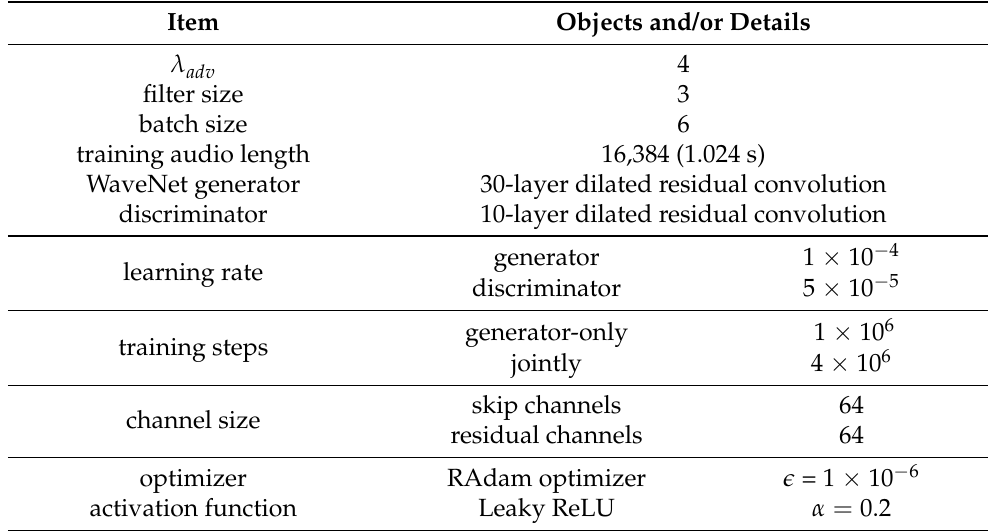
Table 4. Hyper-parameters of